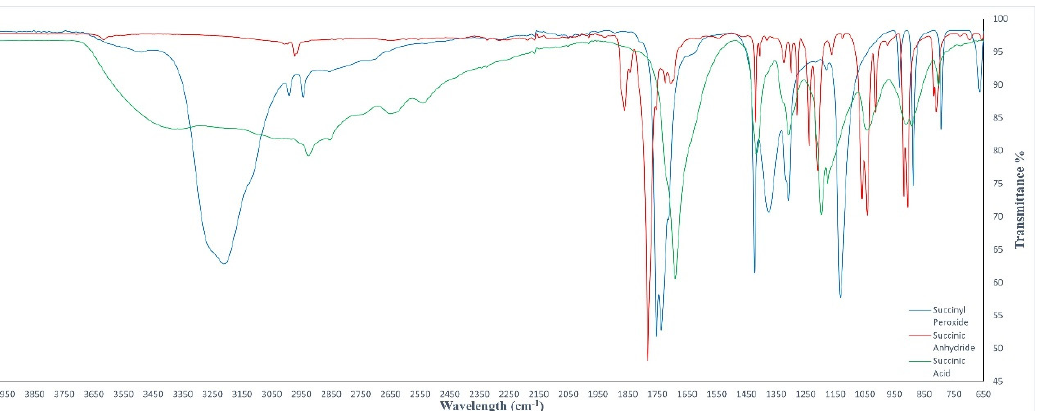
Figure 2. FT-IR ATR spectra of succinic acid (green line), succinic anhydride (red line) and succinyl anhydride (blue line).